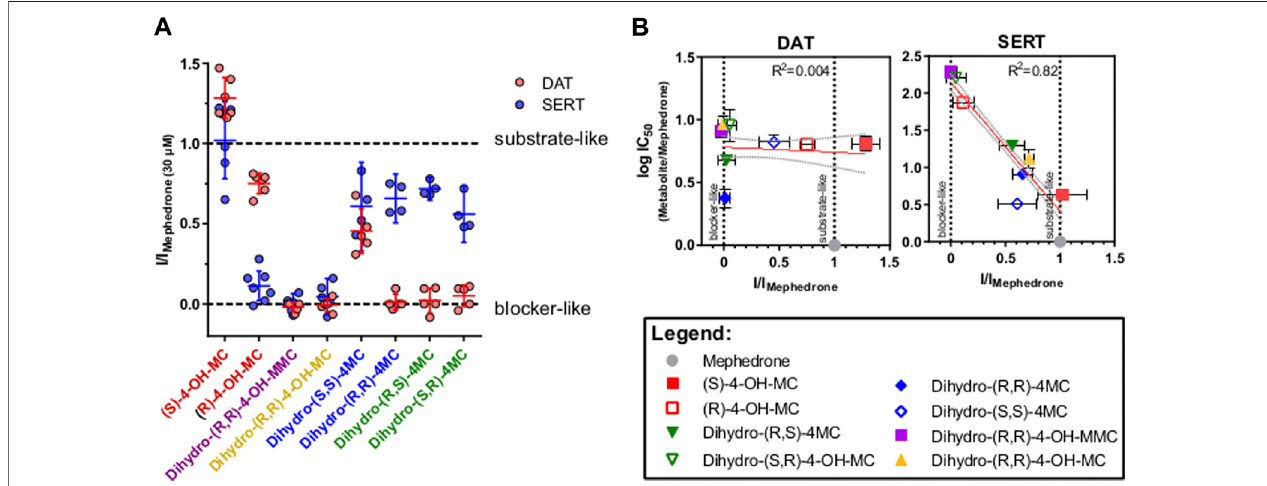
FIGURE4| DAT-andSERT-mediatedcurrentsofselectedmetabolites. (A) normalized steady-statecurrentamplitudeas(I metabolite30µM /I Mephedrone30µM ).Dataare represented as mean and 95% con fi dence interval, with dots representing individual cells (red (cid:2) DAT and blue (cid:2) SERT). On the x axis, the two enantiomers of the same metabolite are depicted with the same color. (B) correlation analysis for changes in current pro fi le and in IC50s. IC50 values of the different metabolites, obtained in the uptake-inhibition experiments, are normalized to the IC50 of mephedrone. The Log10 of this ratio is plotted against the current ratio and subjected to linear regression.Thelinear fi tofthedataisrepresentedbytheorangelinewiththegreydashedlinesdepictingthe95%con fi denceinterval.ForDAT (middle) thereisnolinear correlation ( R 2 (cid:2) 0.004, F (cid:2) 0.299, p < 0.586). For SERT (right) the two measures are linearly correlating ( R 2 (cid:2) 0.82, F (cid:2) 397.8, p < 0.0001).